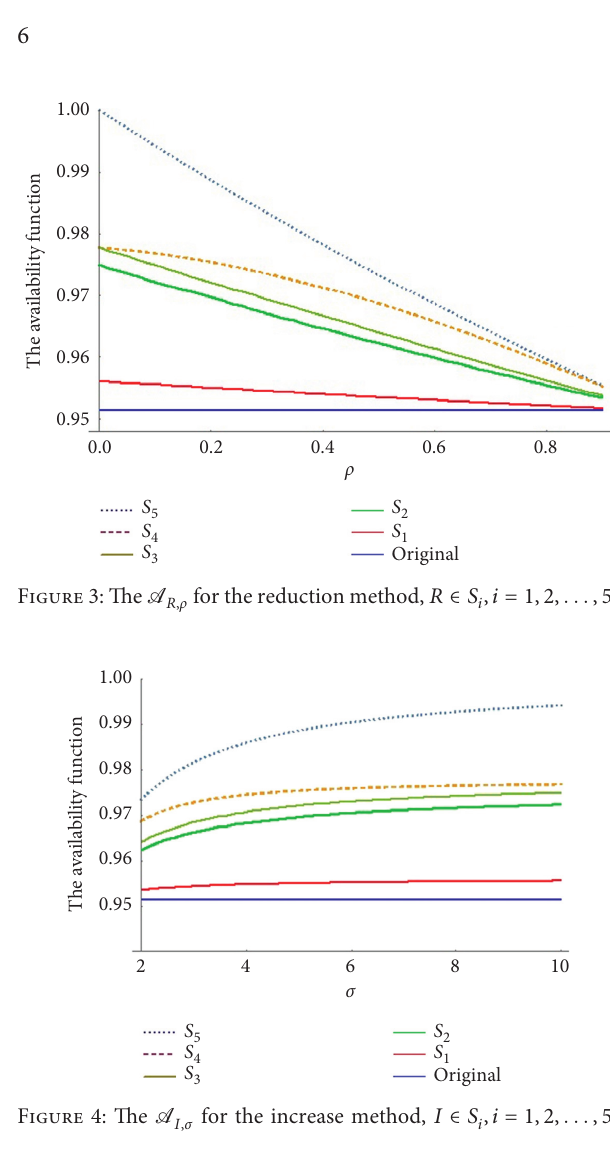
I, σ for the increase method, , D � H ( W , C ) and B ∈ S B